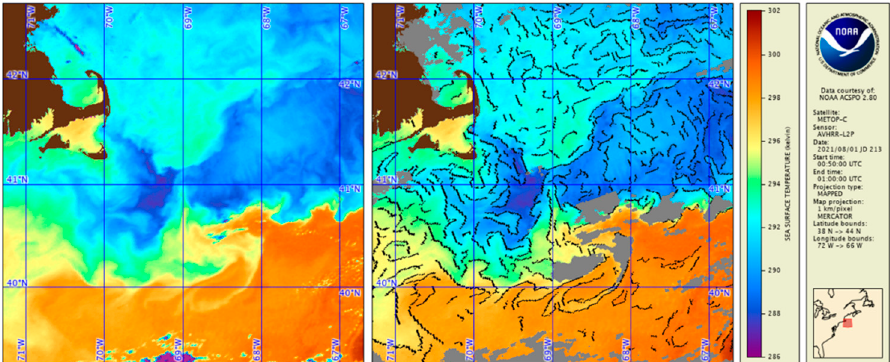
Figure 23. Nighttime maps of GR SST in the Georges Bank/Nantucket Shoals on 1 August 2021. The left map is an ‘all-sky’ SST, the right map applies the ACSPO Clear-Sky Mask (ACSM; rendered in grey) and overlays thermal fronts (in black lines). Maps are taken from the NOAA ACSPO Regional Monitor for SST system (ARMS) [27] . Land is rendered in dark brown.